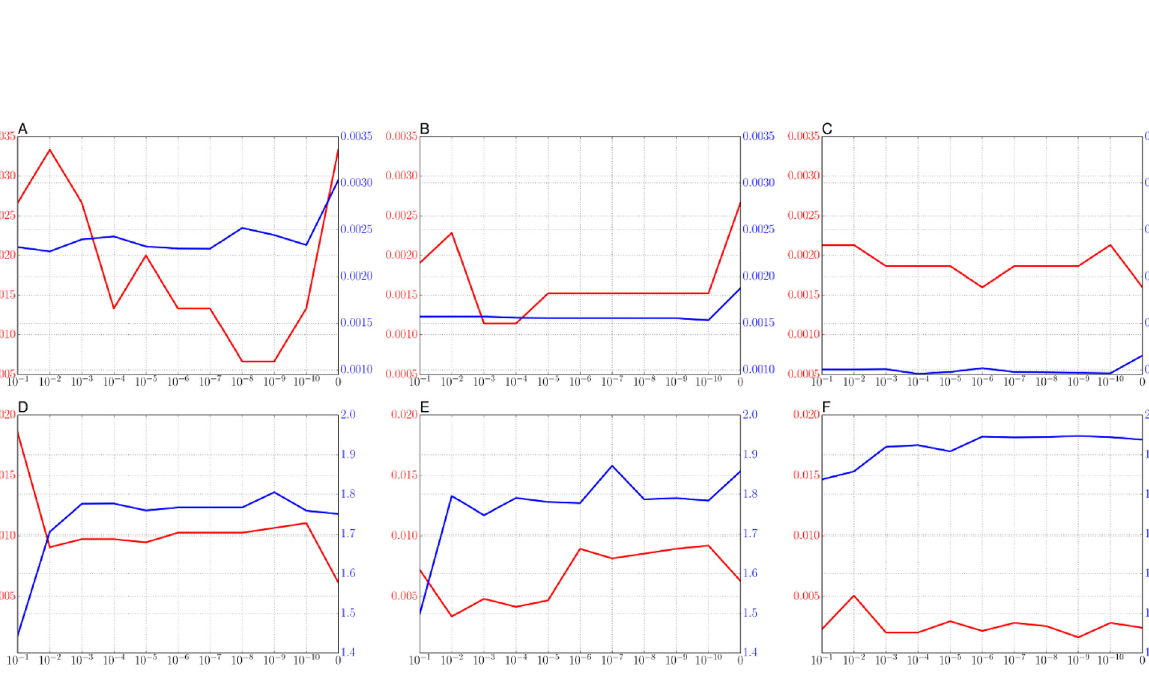
PLOS ONE | https://doi.org/10.1371/journal.pone.0210146 January 10,